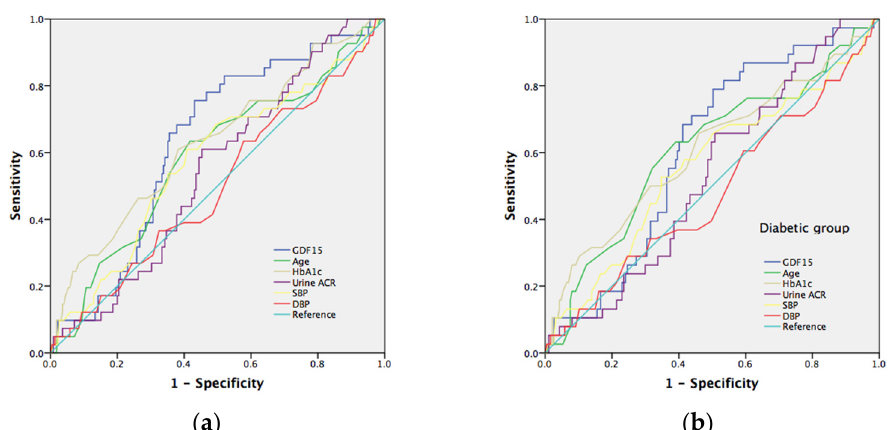
Figure 4. ( a ) . Receiver operating characteristic (ROC) curves and area under the curve (AUC) in prediction of median nerve sensory neuropathy. Blue line: GDF15 risk score (AUC = 0.633; p = 0.007); green line: age risk model (AUC = 0.587; p = 0.078); yellowish-green line: HbA1c risk model (AUC = 0.631; p = 0.008); purple line: urine albumin/creatine risk model (AUC = 0.546; p = 0.354). Yellowish line: systolic blood pressure risk model (AUC = 0.577; p = 0.117). The red line: urine diastolic blood pressure risk model (AUC = 0.497; p = 0.957); light blue line represents the reference line. ( b ) Receiver operating characteristic (ROC) curves and area under the curve (AUC) in predicting median nerve sensory neuropathy. Blue line: GDF15 risk score (AUC = 0.611; p = 0.032); green line: age risk model (AUC = 0.609; p = 0.035); yellowish-green line: HbA1c risk model (AUC = 0.607; p = 0.038); purple line: urine albumin/creatine risk model (AUC = 0.532; p = 0.538). Yellowish line: systolic blood pressure risk model (AUC = 0.559; p = 0.250). Red line: urine diastolic blood pressure risk model (AUC = 0.479; p = 0.687); light blue line represents the reference line.